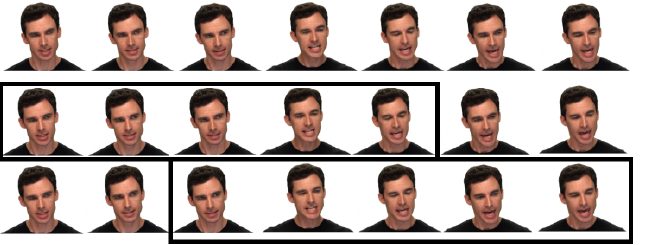
Figure 9. Examples of time dependent augmentation for visual frames. Top part : Original frames. Middle part : Sliced frames start at beginning of the original frames. Bottom part : Sliced frames start at the middle of the original